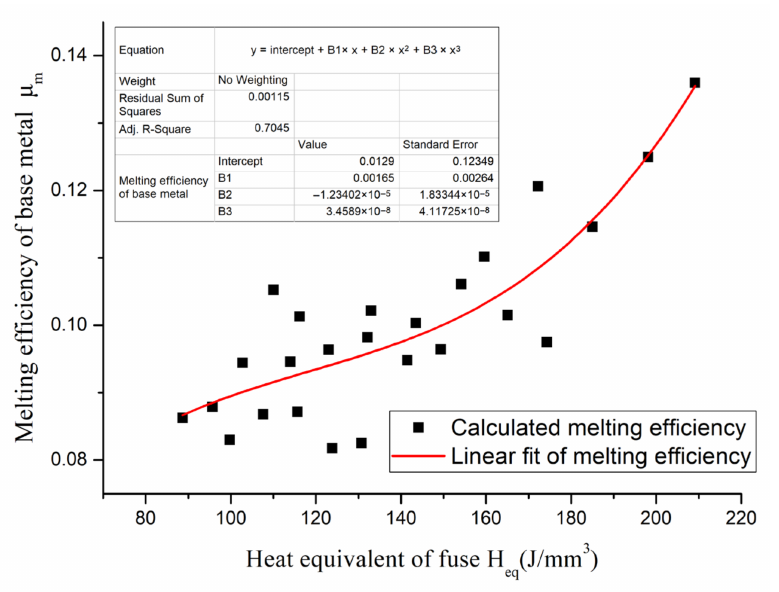
Figure 8. Relationship between the heat equivalent of fuse and the melting efficiency of the base